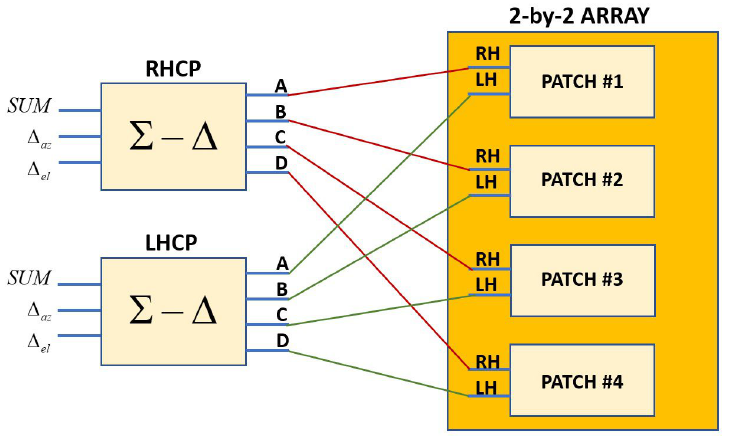
Figure 7. Block scheme of the connections between Σ − ∆ networks and the 2-by-2 array RH/LH CP